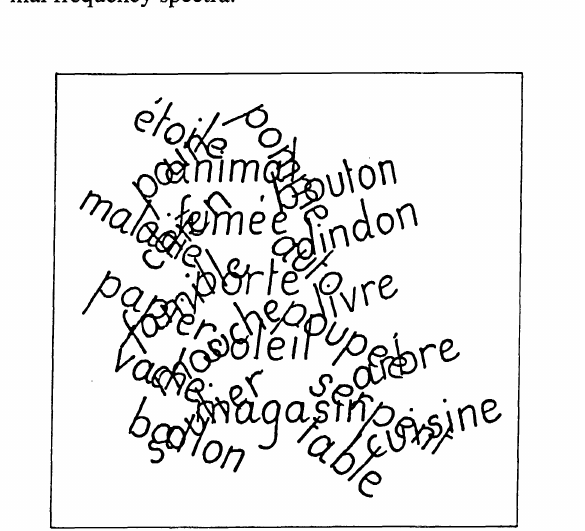
FIG. 1. The Visual Word Desegration task (Rey, 1970). The exam inee is required to identify individually, and read aloud, the follow ing French words: animal, arbre, auto, bailon, bouton, chien, cuisine, dindon, etoile, famille, fumee, livre, magasin, maladie, mouche, pain, papier, pam me, porte, poupee, serpent, saleH, sou lier, sable,